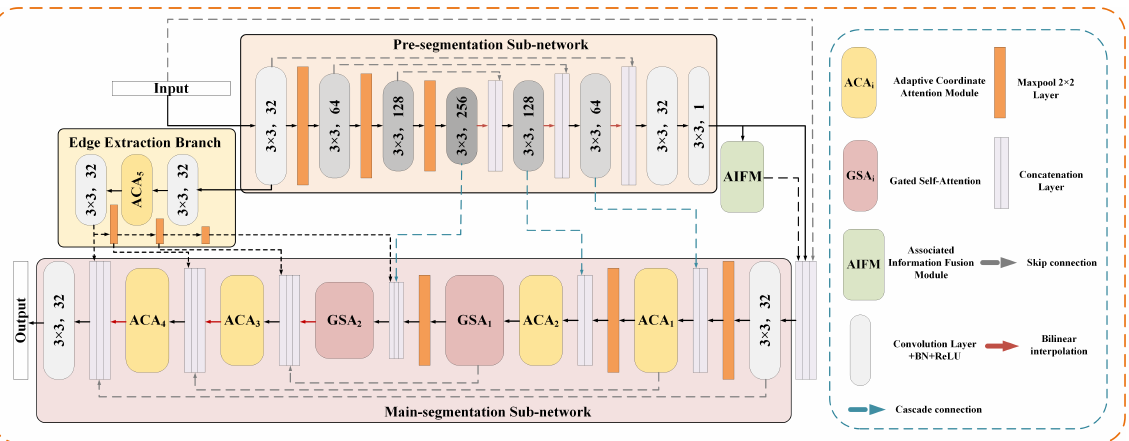
Figure 2. Our proposed multi-feature segmentation network (MF-Net). The 3 × 3 and numbers (1, 32, 64, 128 and 256) in the gray rounded rectangle correspond to the size of the convolution kernel and the number of output channels, respectively. The network consists of the pre-segmentation network (orange box), the main-segmentation network (pink box) and the edge extraction branch (yellow